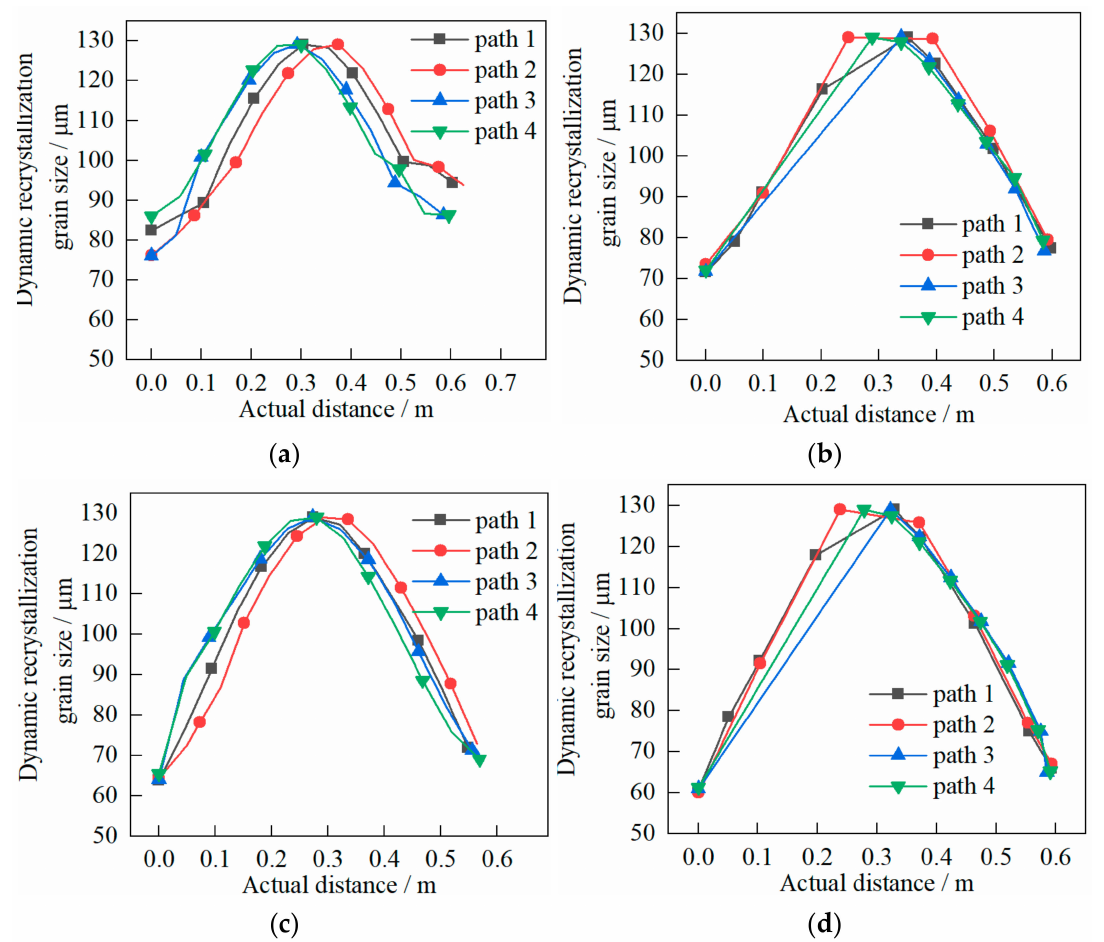
Figure 19. Evolution characteristics of recrystallization grain size in two passes of rolling: ( a ) first pass rolling, without shear effect; ( b ) first pass rolling, with shear effect; ( c ) second pass rolling, without shear effect; ( d ) second pass rolling, with shear